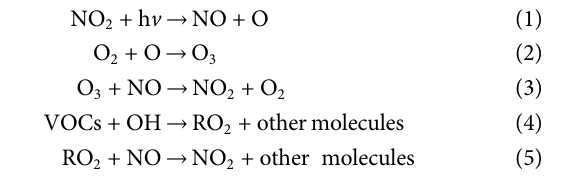
Frontiers in Environmental Science |